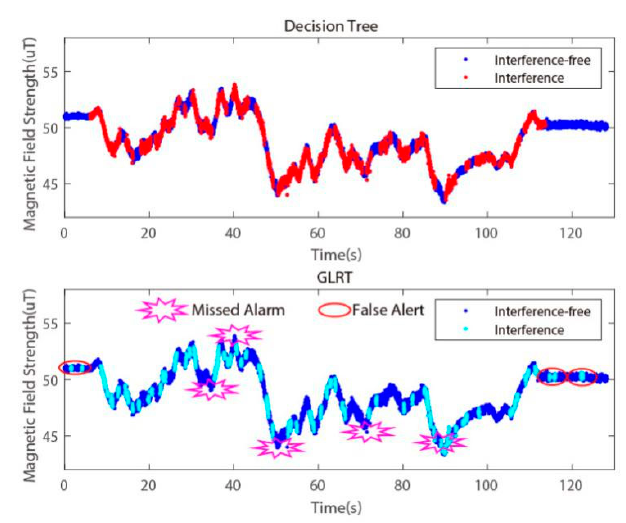
Figure 16. The magnetic data classification result generated by the Decision Tree and GLRT. ( a ) The red dots mark the interference measurement. ( b ) The cyan dots mark the interference measurement; the missed alarms and false alerts of the magnetic interference dots are also marked.